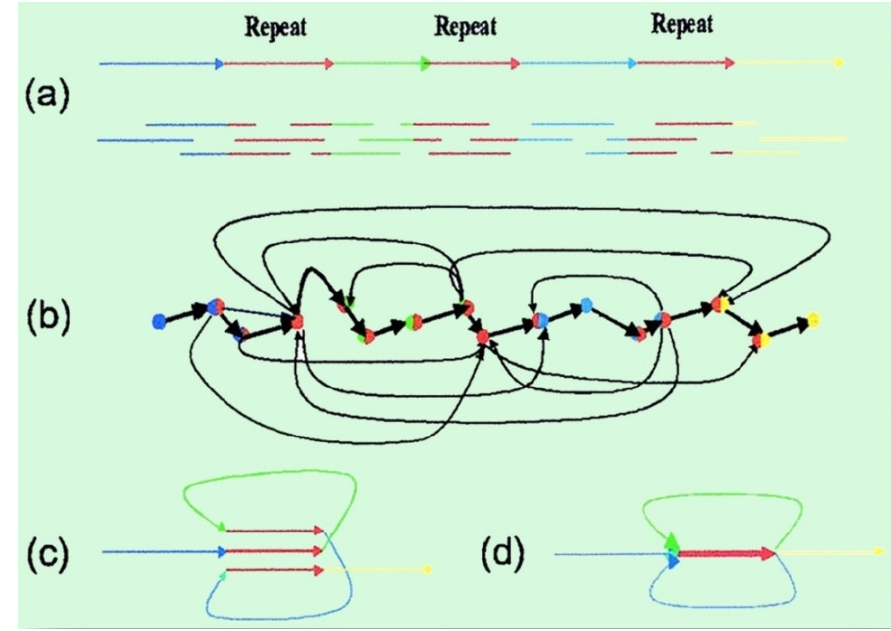
Figure 4. Steps of construction of de Bruijn graphs [24,32,34].